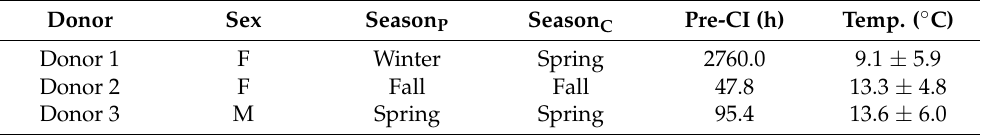
Table 1. Demographic information and pre-colonization data for each donor used in this